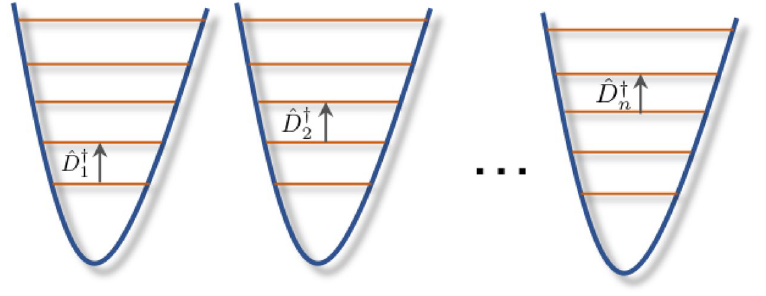
Figure 1. A physical system for simulating Diophantine equations with n variables. The system is either n trapped ions or an n –mode coherent field. The controls ˆ † D , … , ˆ † D independently address each subsystem. For 1 n ions, the controls excite transitions between nearest levels, and transfer population of the highest excited state down to the ground state. For coherent states, the control for the i -th mode is the displacement ˆ D by the i magnitude one. The Diophantine polynomial is embedded in the observable ˆ O whose expectation value has to be optimized as the control goal. A highly non-trivial example corresponds already to the simple case of a two- mode coherent field ( n = 2) with , where α , β , and γ are positive integers. The observable is non-linear but physical; its leading term is of the Kerr-type nonlinearity. Maximizing the expectation of this observable is NP-hard, i.e., it is at least as hard as the famous Traveling Salesman Problem. Note that an n = 9 system is sufficient to solve any Diophantine